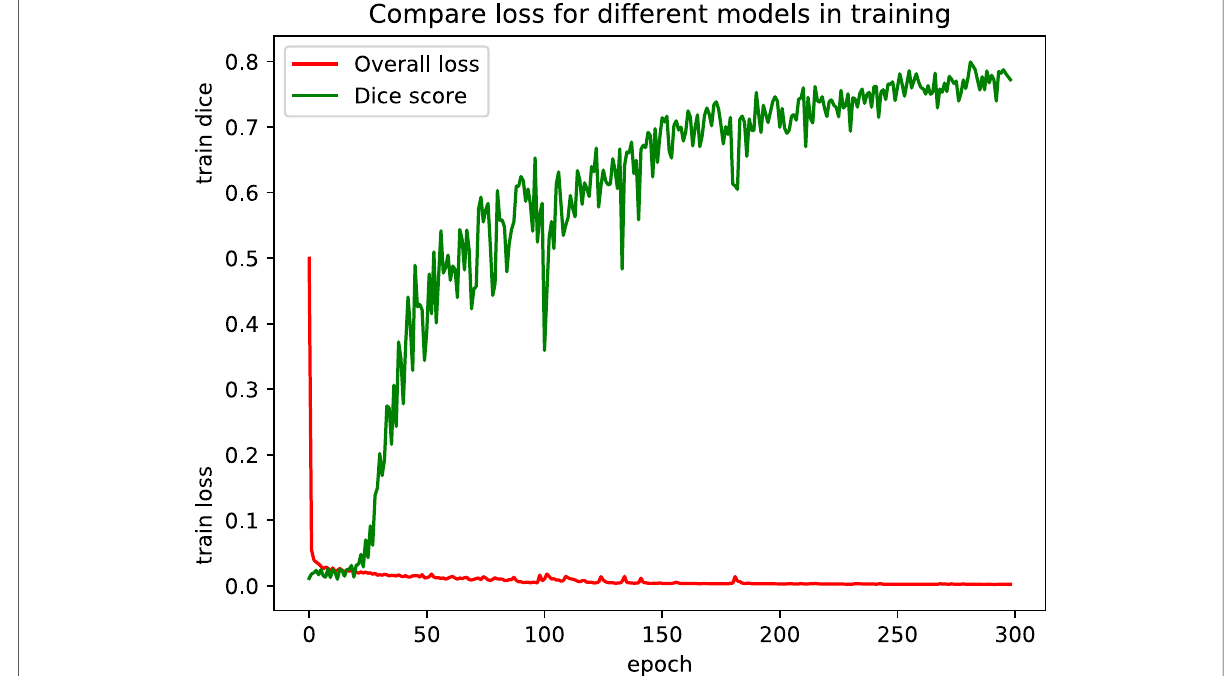
Fig. 5 Evolution of the overall loss functions and dice score during the 300 rounds of training, for the MICCAI 2020 ADAM dataset